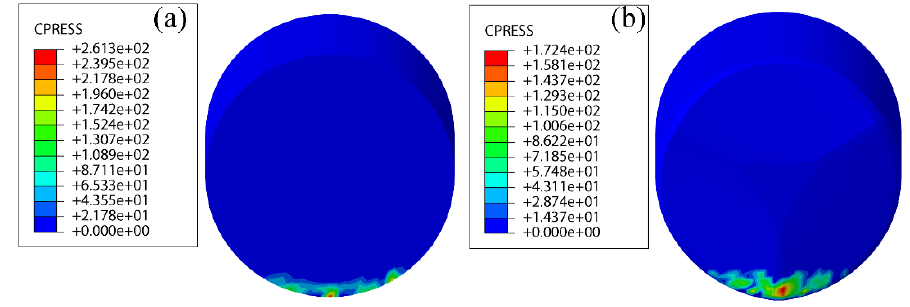
Figure 8. Contact stress in rock-cutting process: ( a ) Conventional cutter; ( b ) 3-RDE cutter.